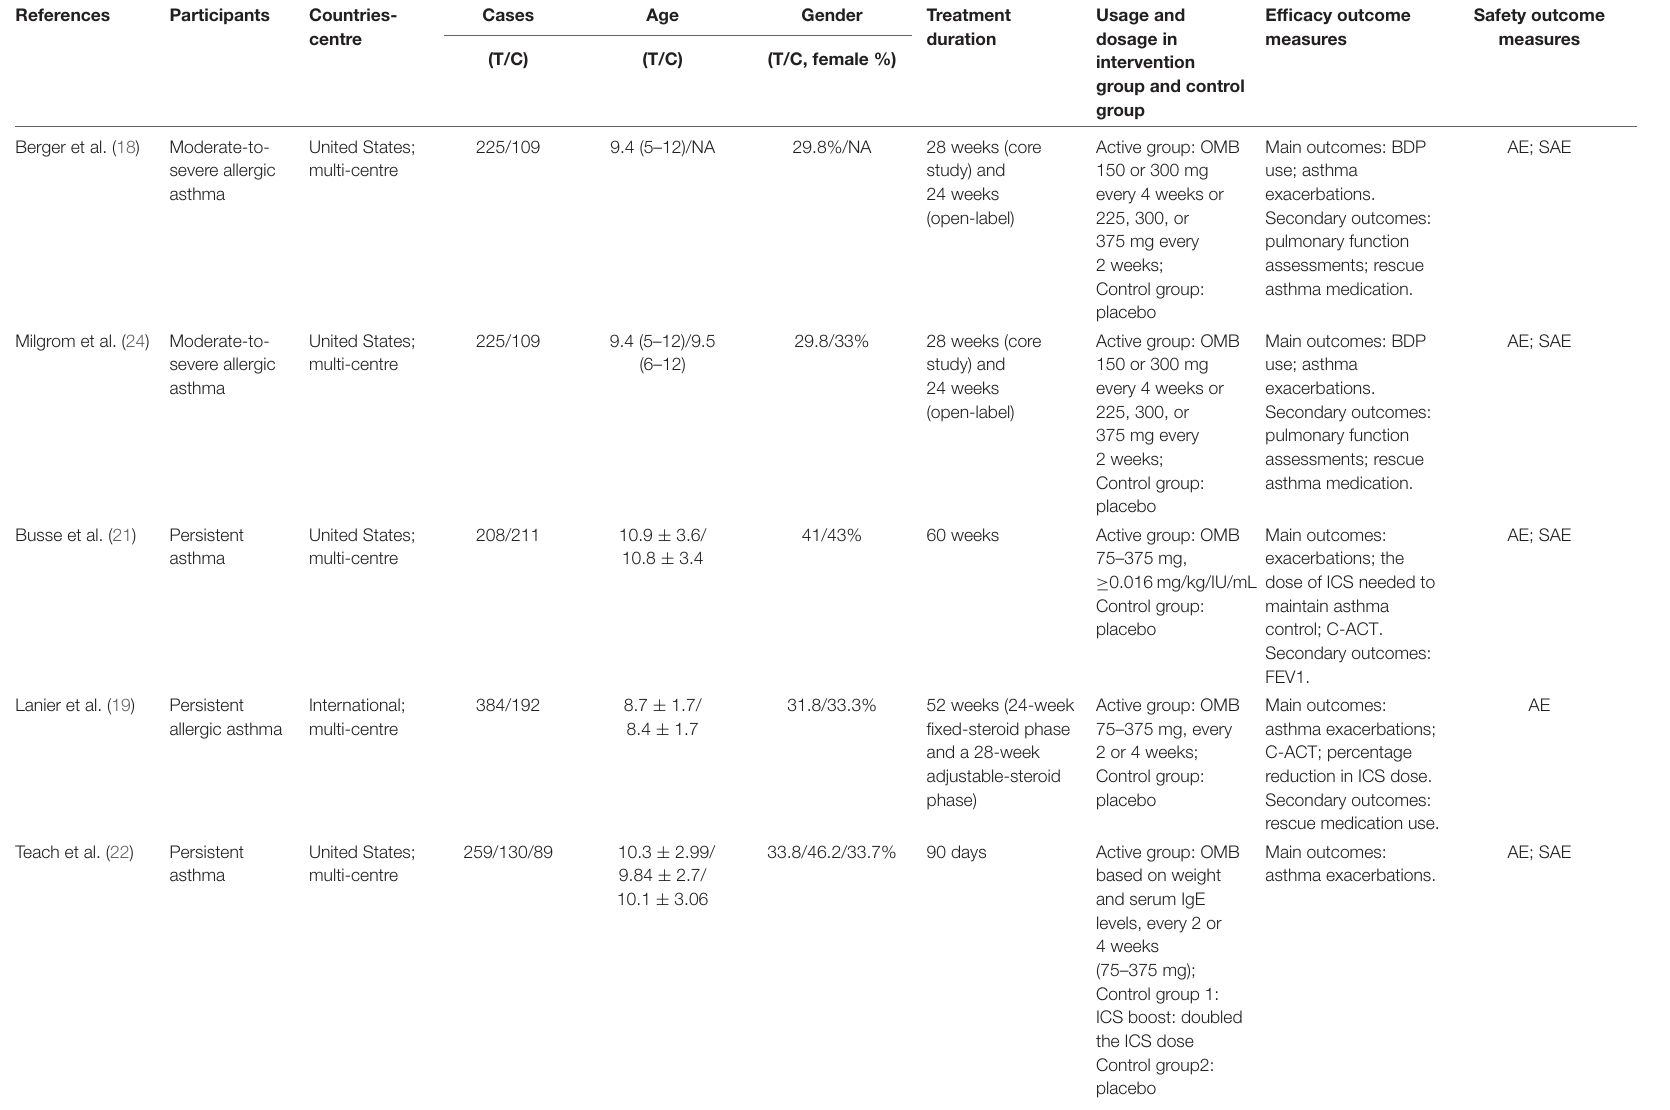
TABLE 1 | Basic characteristics of included